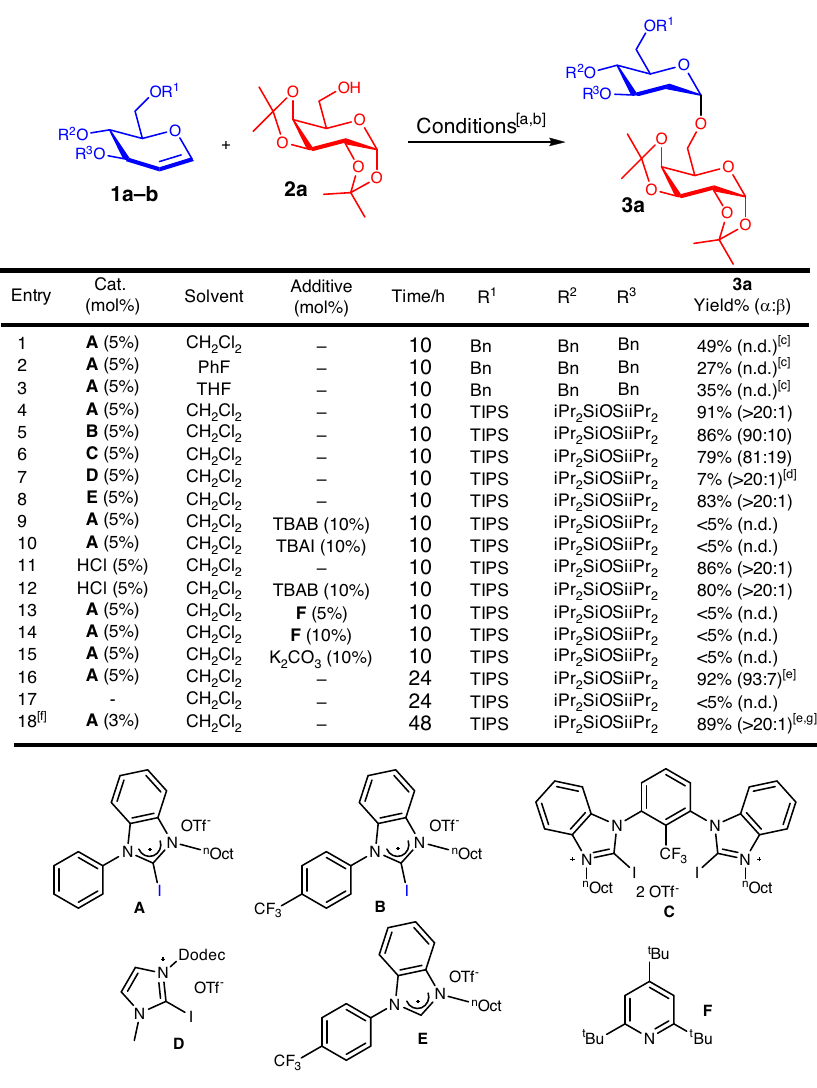
Fig. 2 Optimization of XB-catalyzed 2-deoxyglycosylation. [a] 2a (0.1 mmol), 1a – b (0.15 mmol), catalyst, 50 °C, solvent (0.2 M), time, argon. [b] Yield and α : β ratio were determined by crude 1 H NMR spectra analysis using 1,3,5-trimethoxybenzene as an internal standard. [c] 40 – 50% NMR yields of Ferrier rearrangement side-products detected. [d] 92% 1b remaining. [e] 2a (0.2 mmol), 1b (0.30 mmol), catalyst, 50 °C, CH 2 Cl 2 (0.2 M), time, argon.